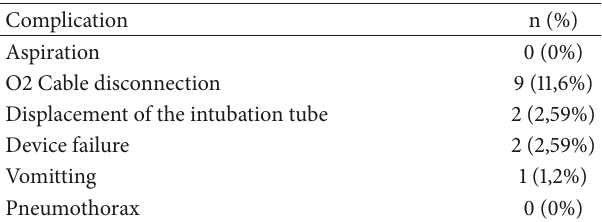
Table 5: Device-related complications during